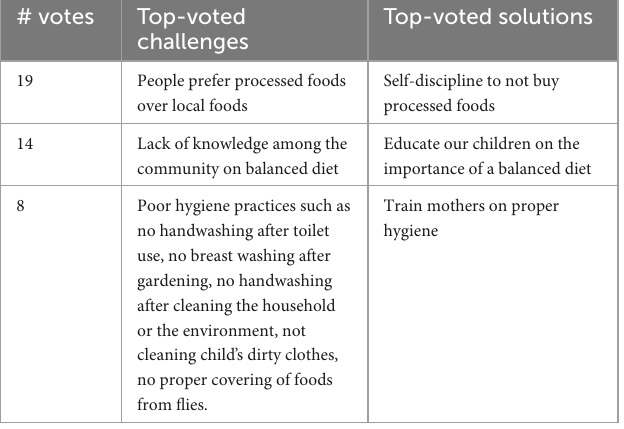
TABLE 7 Challenges and solutions for improving infant and child nutrition in Malango